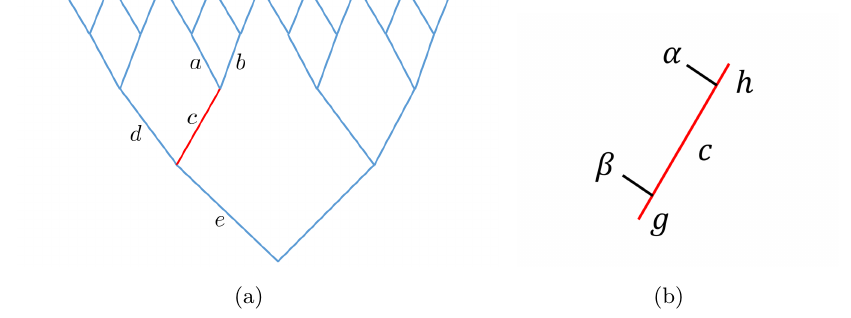
and ˜ V a following from the contraction of tensors above (colored red) and Figure 2 . Vector V a xy xy below (colored green) the edge h xy i respectively. The boundary conditions V Λ from the fixed point vector. The curvature of the patch centered at x depends on the graph distances symmetrically. d h xy i i